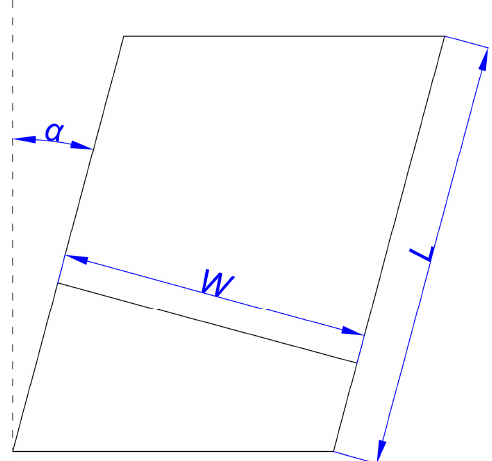
Figure 1. Geometric definition of length, width, and skew